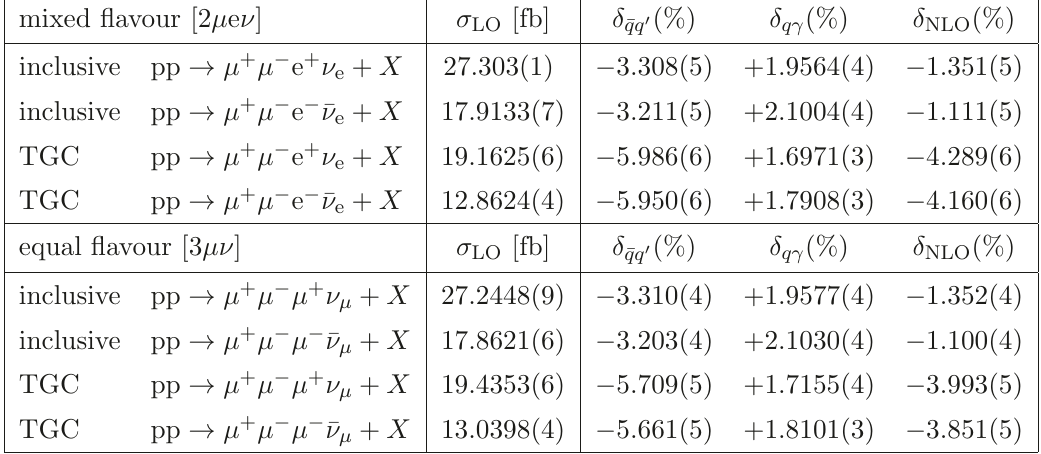
Table 1 . Fiducial cross sections with first-order quark-flavour mixings for all considered final states in the inclusive and TGC